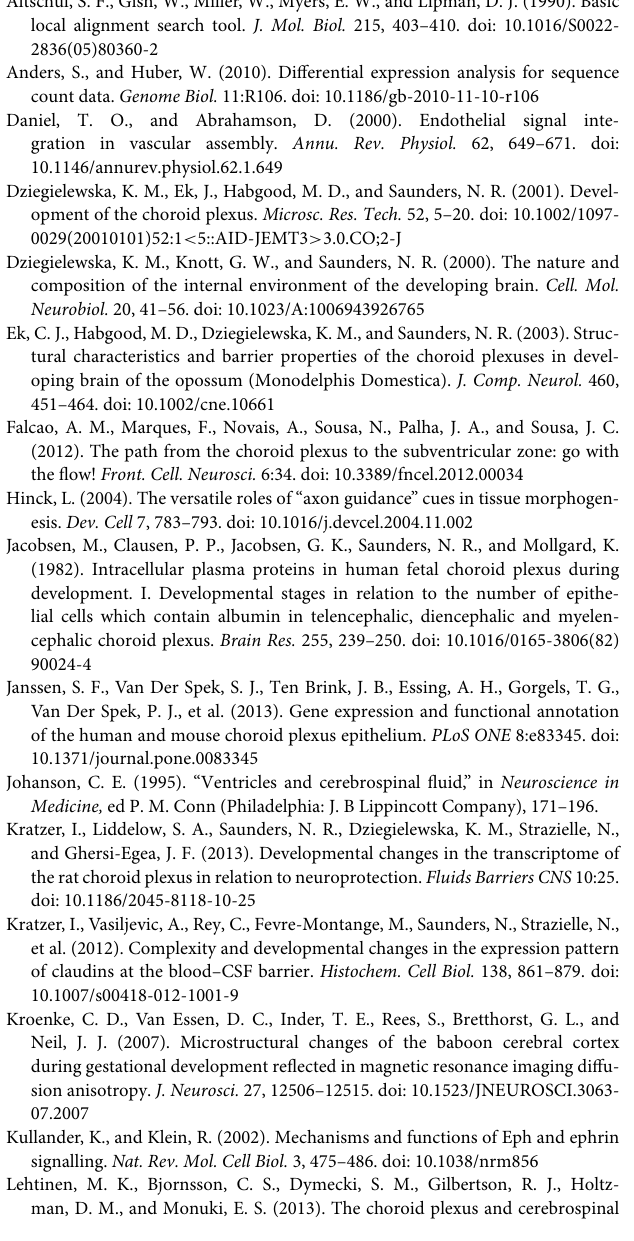
Supplementary Figure 1 | Diagrams of canonical ephrin signaling pathway showing up (red) and down (green) regulated genes between GD90 and GD165 along with predictions on biological functions. Supplementary Figure 2 | Diagrams of canonical CDK5 signaling pathway showing up (red) and down (green) regulated genes between GD90 and GD165 along with predictions on biological functions.